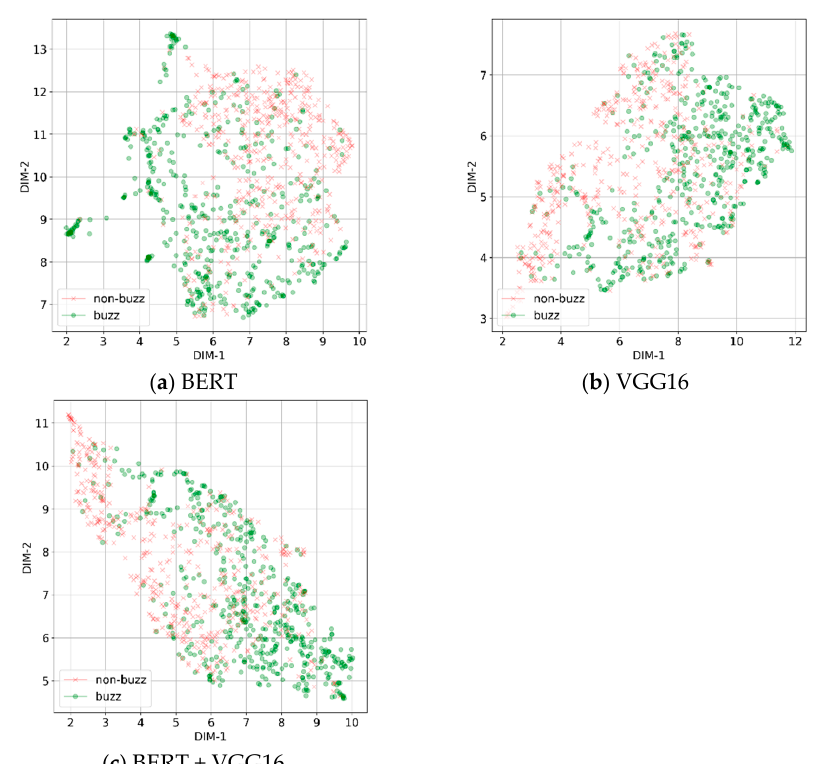
Figure 11. Visualization of BERT, VGG16 and BERT + VGG16 for each buzz/non-buzz tweet.